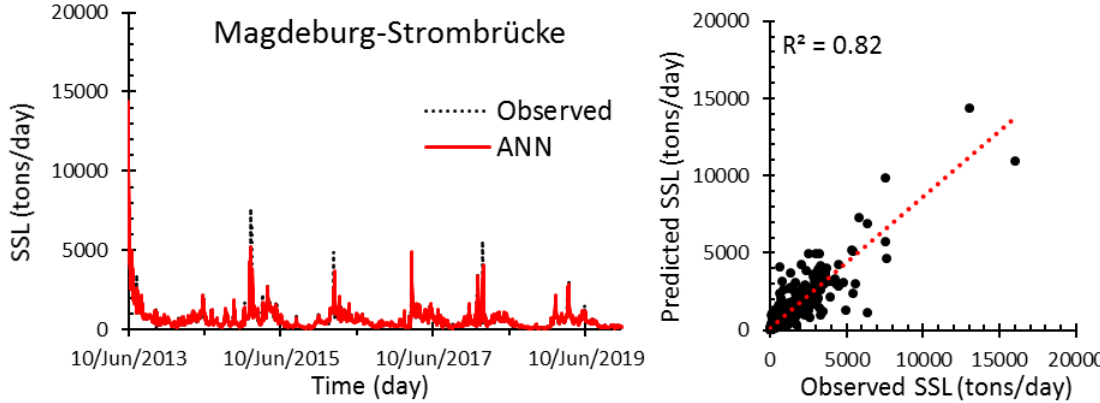
Figure 14. Observed versus predicted SSL of the best ANN model for the Magdeburg-Strombrücke station in a testing phase.